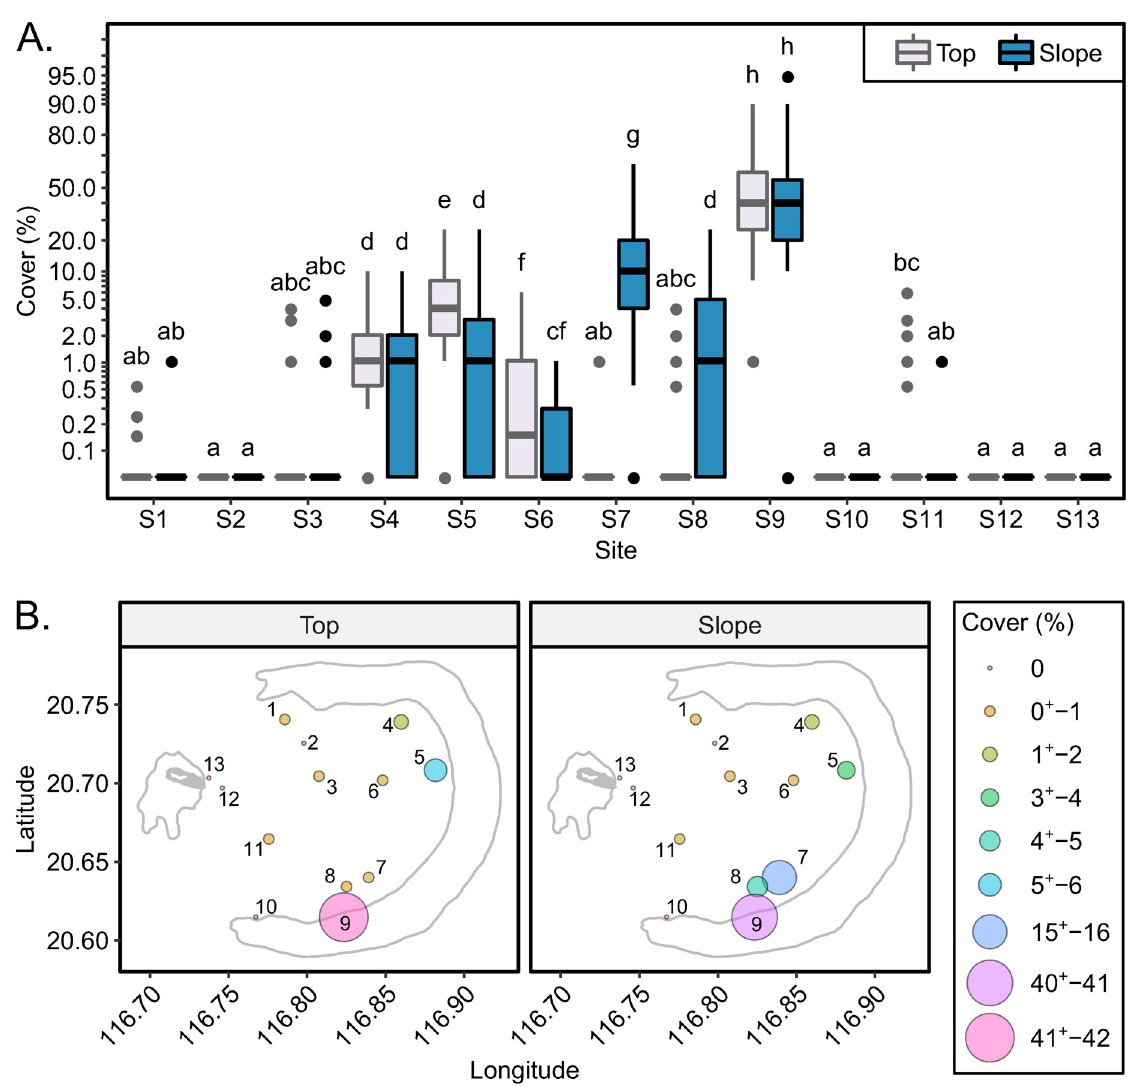
Fig 3. Spatial variation in G . divaricata in the Dongsha lagoon. (A) Boxplots showing variation in the percent cover of G . divaricata between reef top and slope among 13 sites. Labels denote the ranks of percent cover according to multiple comparisons among 26 transects. Labels that with different letters indicate a statistical difference (posterior Cohen’s d > 0.2) in the G . divaricata cover. (B) The average percent cover on the reef top and slope at each site are represented by circles with different colors and sizes. on the slope of site 7 (16%) (Fig 3A and 3B). Patch reefs in the northeast lagoon exhibited much lower cover of G . divaricata (range: 0.21–5.7%) (Fig 3A and 3B and S6 Table). Survey sites in the south, center, west, and north of the lagoon were characterized by the lowest cover of G . divaricata (range: 0–1.4%; Fig 3B and S6 Table). During our survey, we observed that the thallus shape and size of G . divaricata varied across sites (S3 Fig). Small ball-shaped or slender thalli were dominant on patch reefs in the northeast lagoon, while medium ball-shaped and large, carpet-like thalli were exclusively present in the southeast lagoon. Our DNA barcoding analyses confirmed that all samples across sites were 100% identical in their rbc L sequences, indicative of conspecificity (S3 Table).